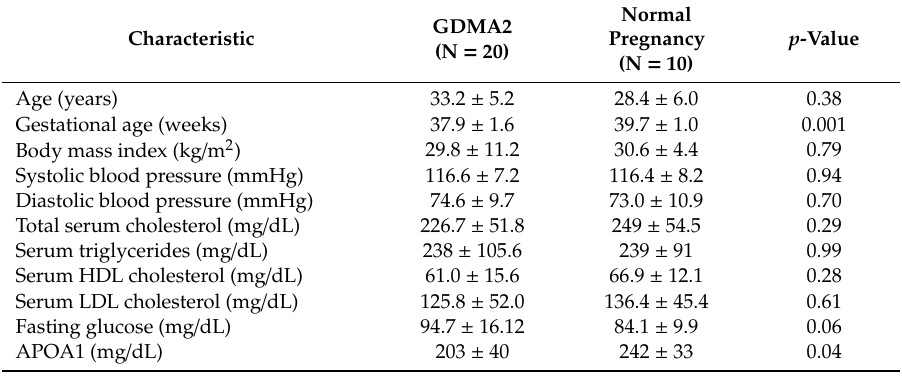
Table 1. Demographic and clinical characteristics of pregnant women with gestational diabetes mellitus type 2 (GDMA2) and of healthy women during an uncomplicated pregnancy. HDL: high-density